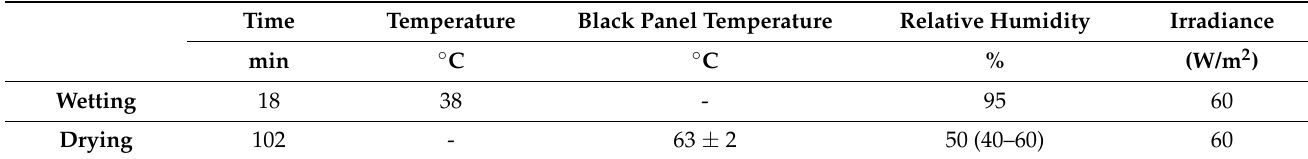
Table 3. The method of accelerated aging